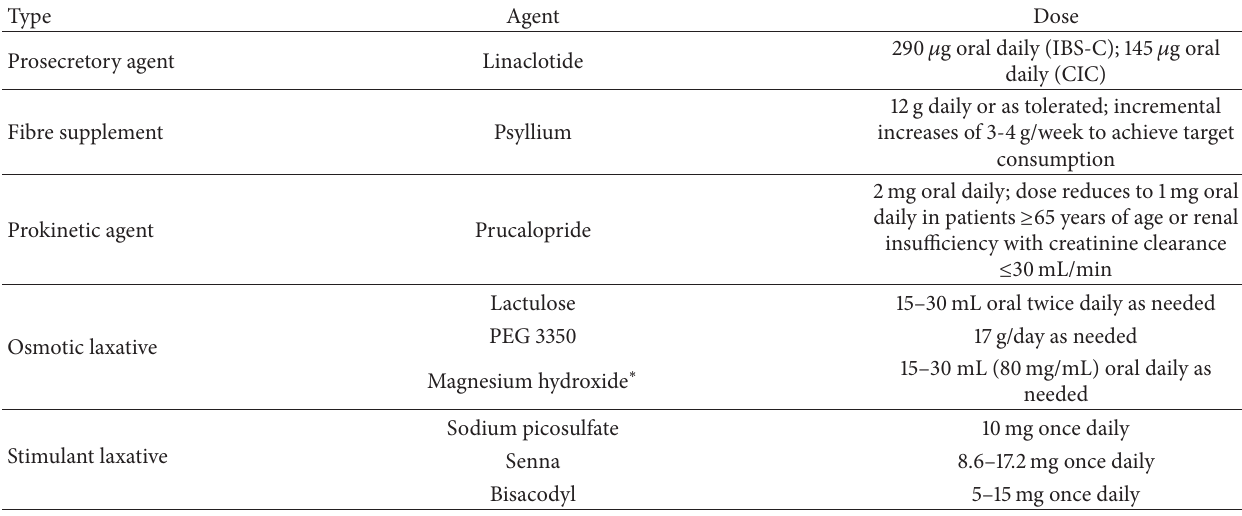
Table 2: Current recommended dosages of pharmacological agents for the treatment of